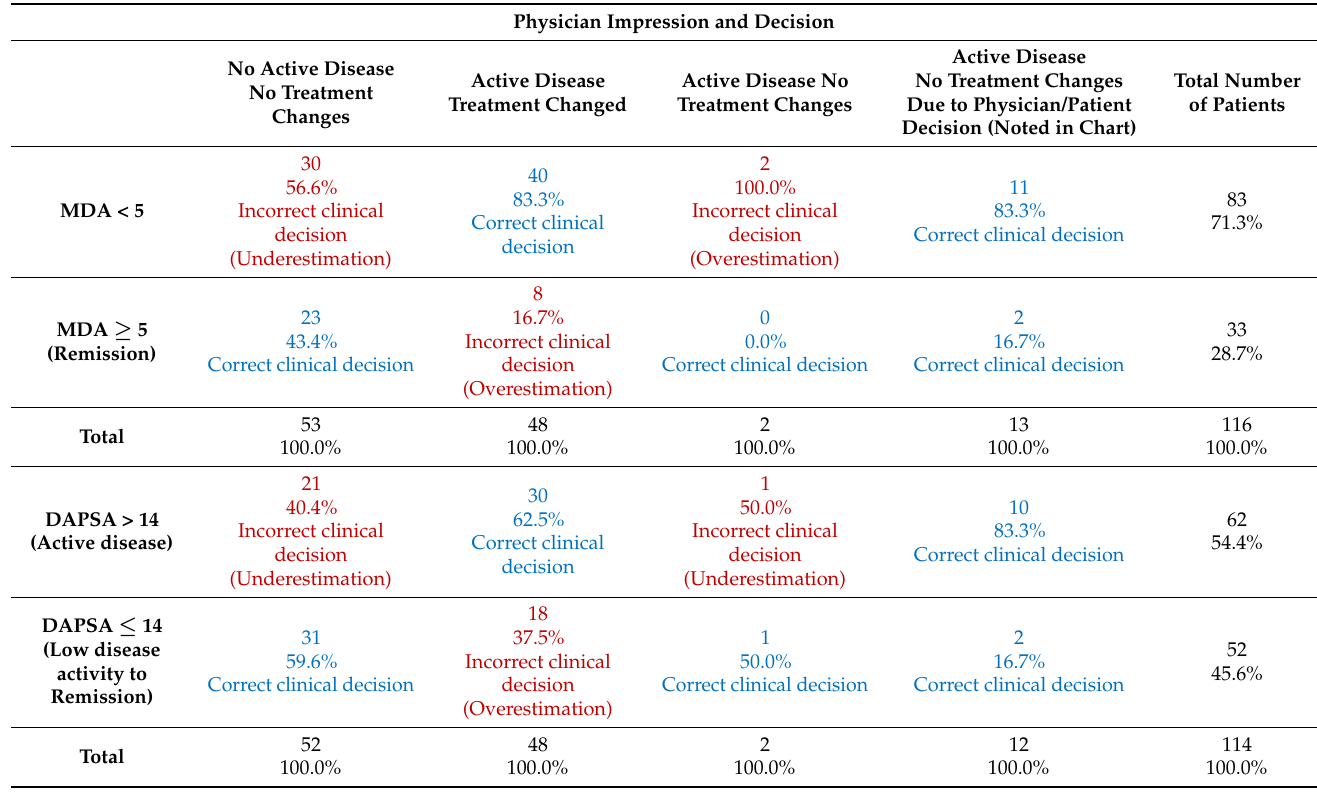
Table 2. The degree of concordance between treatment decision. Based on clinical judgment to validated MDA and DAPSA scores.